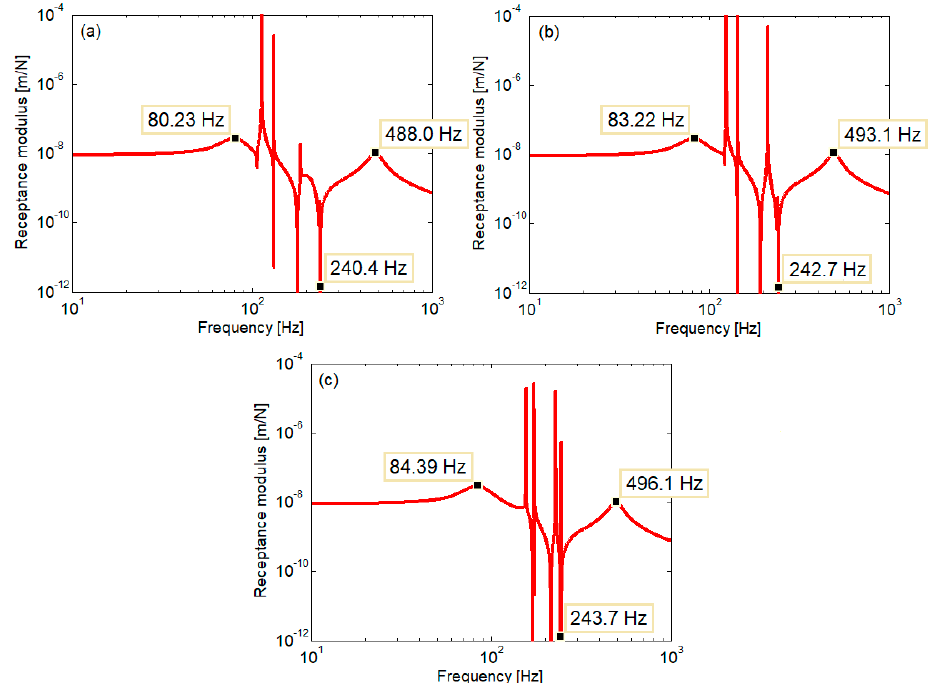
Figure 13. Homogeneous two-layer model of the track.